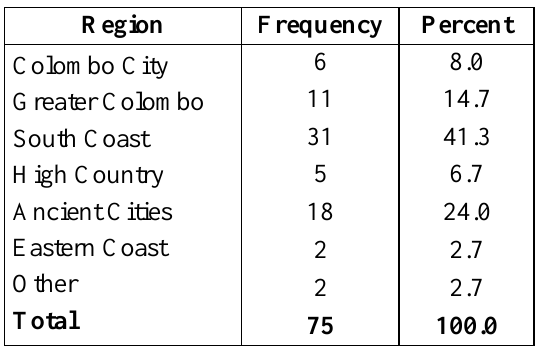
Table 1: Regions of Respondent